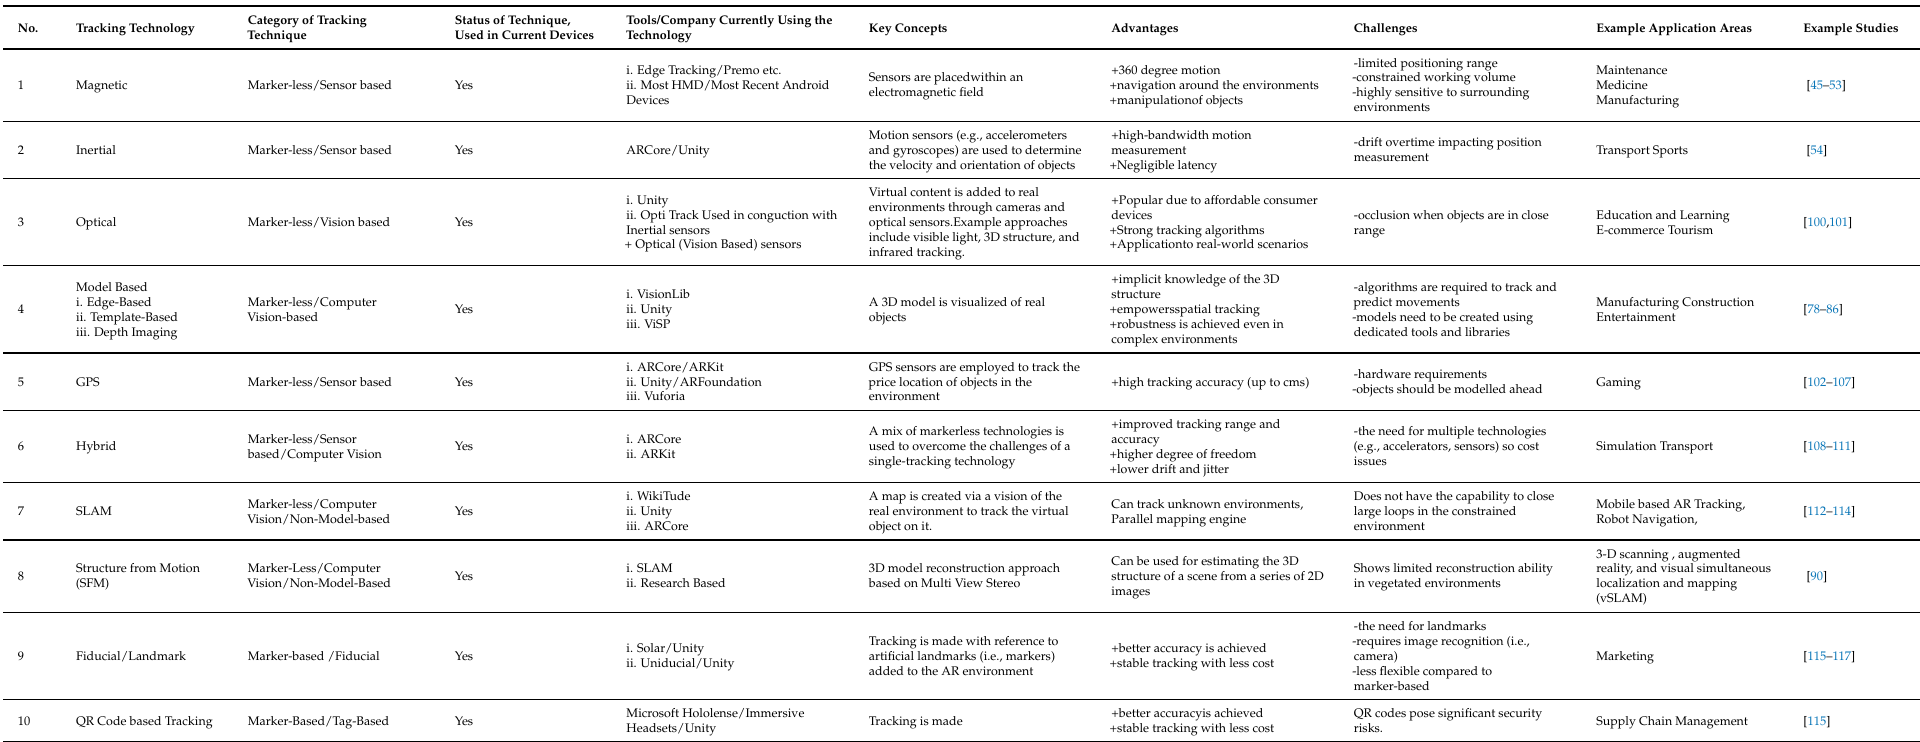
Table 1. Summary of tracking techniques and their related